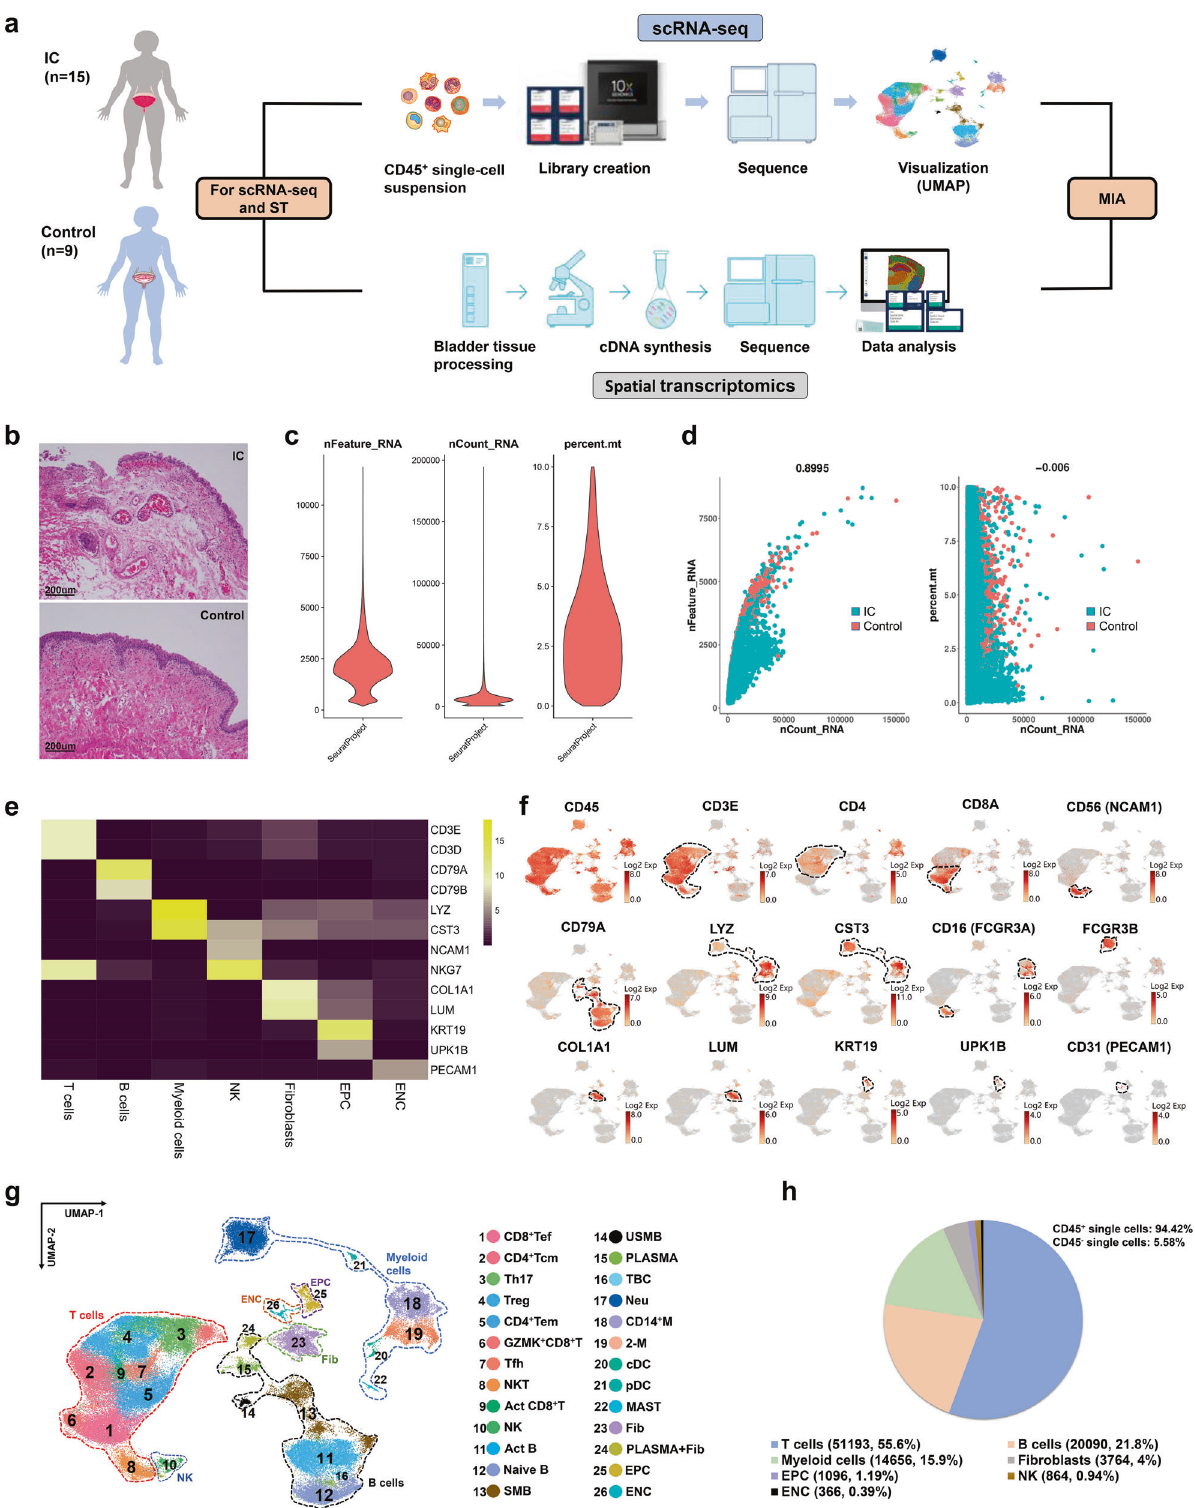
Classi fi cation and annotation of myeloid-cell clusters revealed immune-related macrophages We then delineated the molecular and functional differences in myeloid cells. Six cells types were identi fi ed, including neutrophils (CXCR2 and FCGR3B), in fl ammatory CD14 + Signal Transduction and Targeted Therapy (2022)